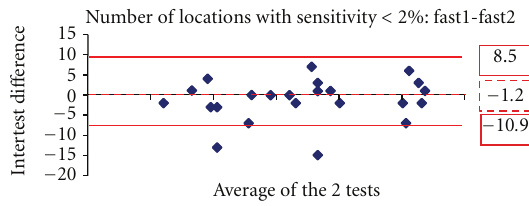
Figure 6: The Bland-Altman plot showing agreement in number of depressed points at least at P < 2% between the first and second visit 10-2 SITA fast tests. The dashed line marks the average di ff erence between the two algorithms. The solid lines mark the upper and lower limits of the 95% limits of